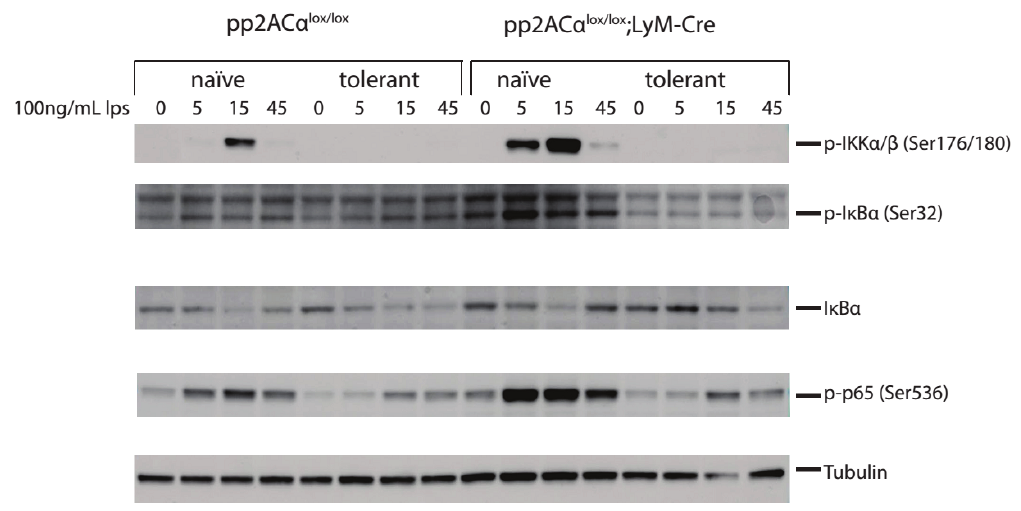
Figure 6. Effects of LPS tolerance and PP2AC(cid:2) knockout on NF(cid:3)B/I(cid:3)B signaling. Elicited peritoneal macrophages were isolated from control PP2AC(cid:2) l ° x/l ° x mice and PP2AC(cid:2) l ° x/l ° x ;lyM- Cre mice. Both cells were pre-treated with (tolerant) or without (naïve) 100 ng/mL LPS for 24 h. Cells were then washed and re-stimulated with second LPS for 0, 5, 15 and 45 min. Cell lysates were subjected to protein gel electrophoresis and western blot analysis with phospho-protein specific antibodies and endogenous control antibody.